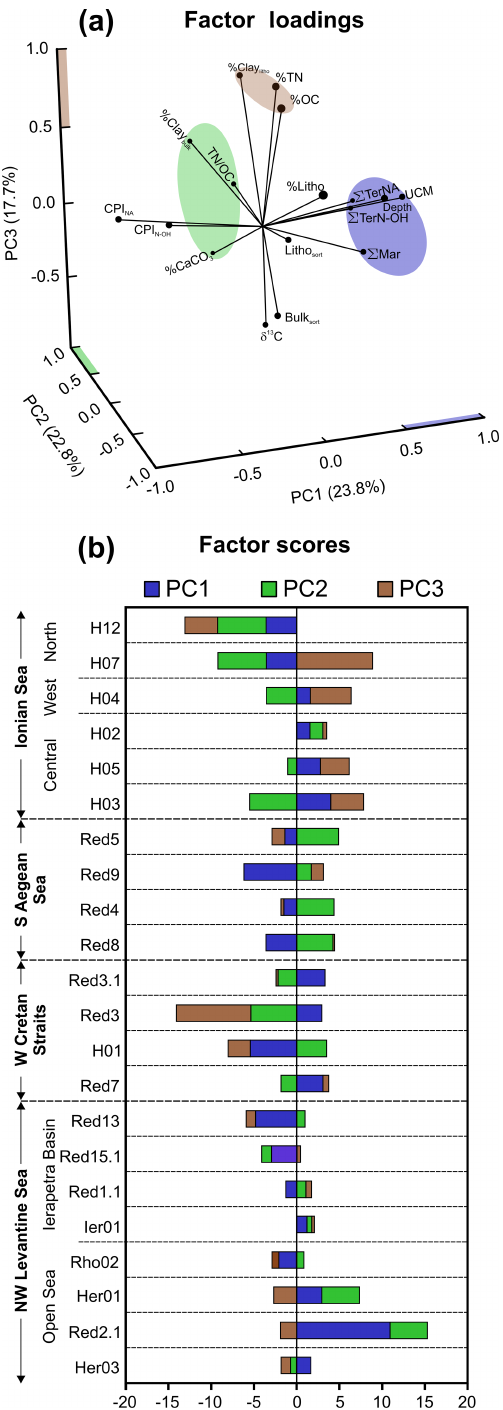
Figure 5. (a) Scatter plot of the factor loadings of the three principal components obtained in the principal component analysis; (b) plot of the scores found at each station. Abbreviations of lipid biomark- ers are defined in the